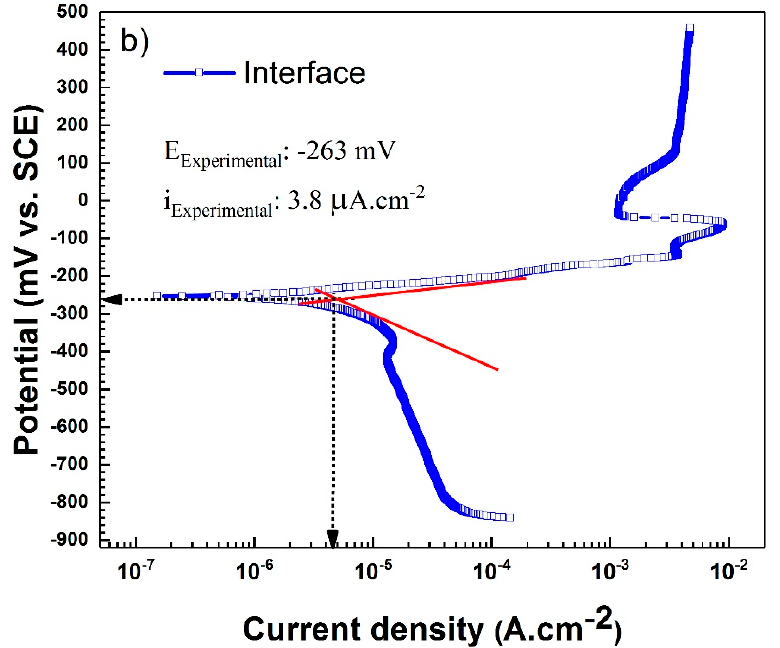
Figure 10. The plots of potentiodynamic polarization in 3.5 wt.% NaCl solution: ( a ) uncoupled Cu and Ti surfaces along with theoretical galvanic current and potential; ( b ) weld interface with 1:1 surface ratio along with experimental galvanic current and potential.